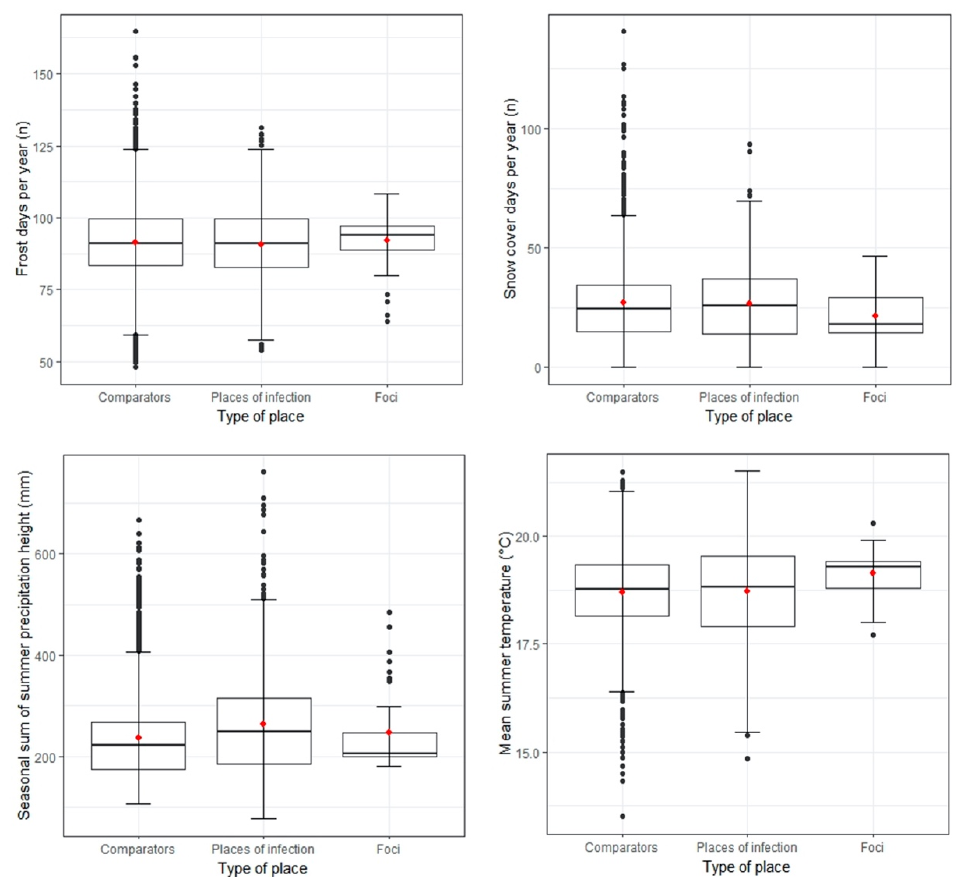
Figure 2. Distribution of selected covariates for comparator places ( n = 1701), POI ( n = 567), and natural TBE foci ( n = 41) from 2018–2020; the red dots in the boxplots are the means. Environmental characteristics of further ecological covariates after variable inflation factor (VIF) selection are displayed in Figure S3.